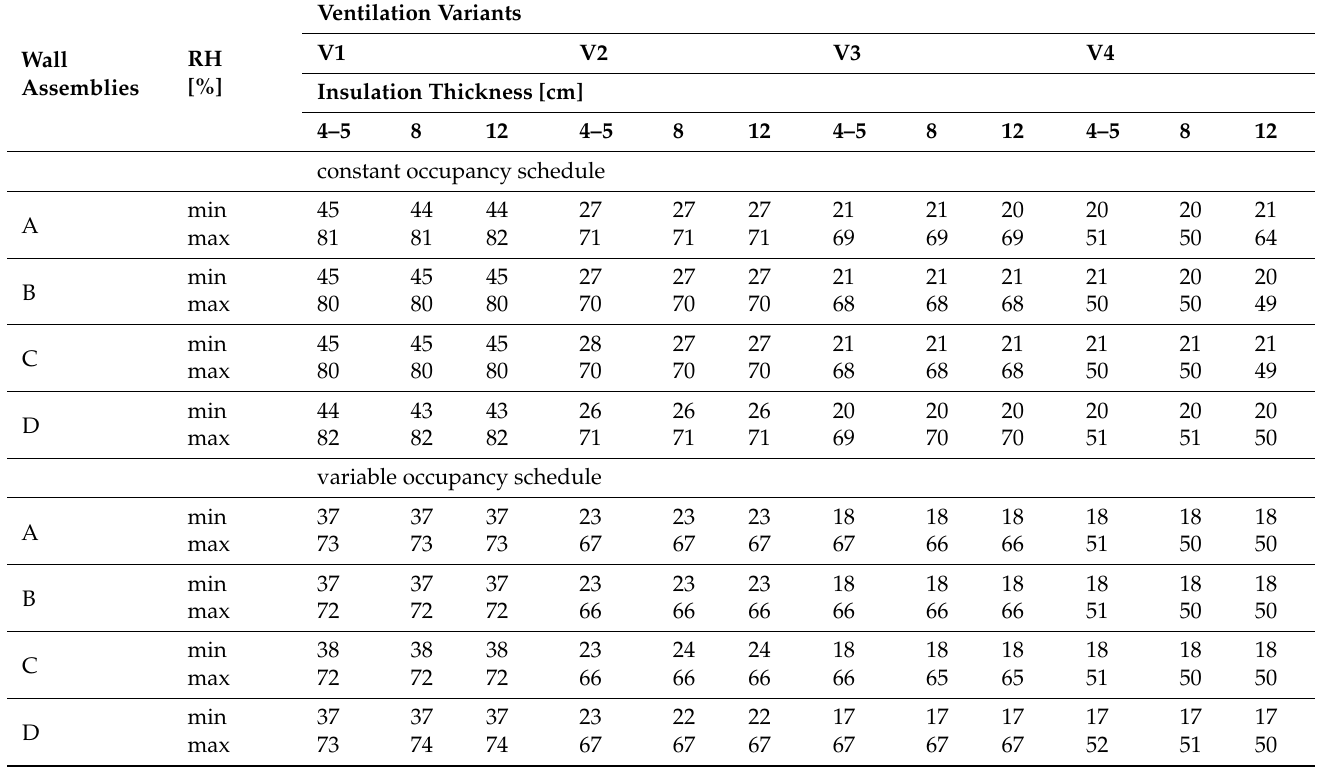
Table 6. Maximum and minimum values of RH on the inner surface of the